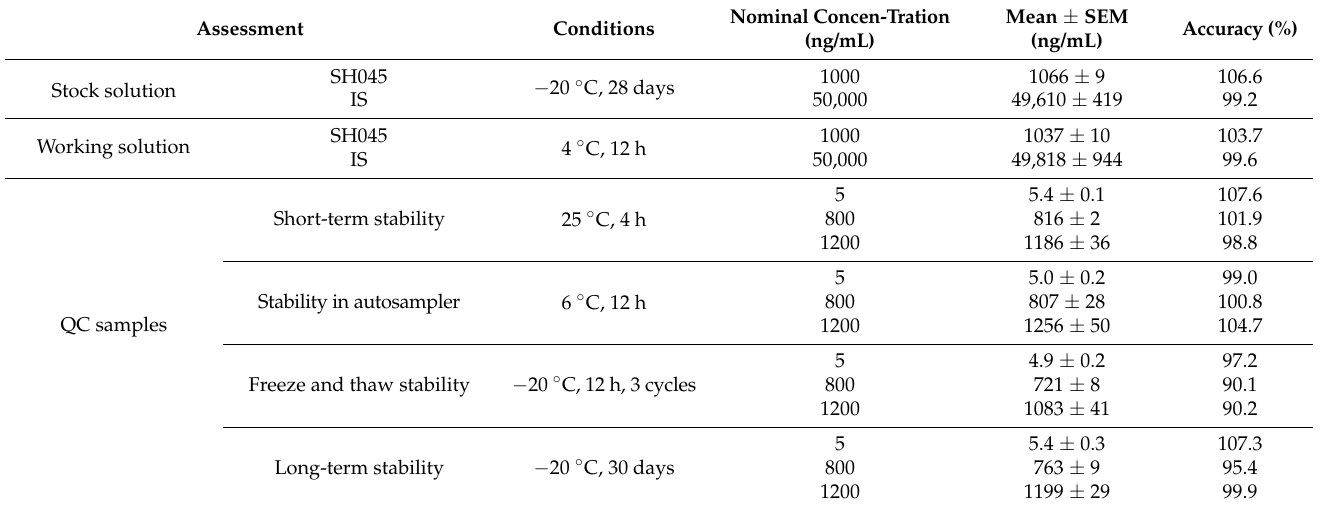
Table 4. The stability of SH045 in working solutions and plasma samples ( n = 3) .